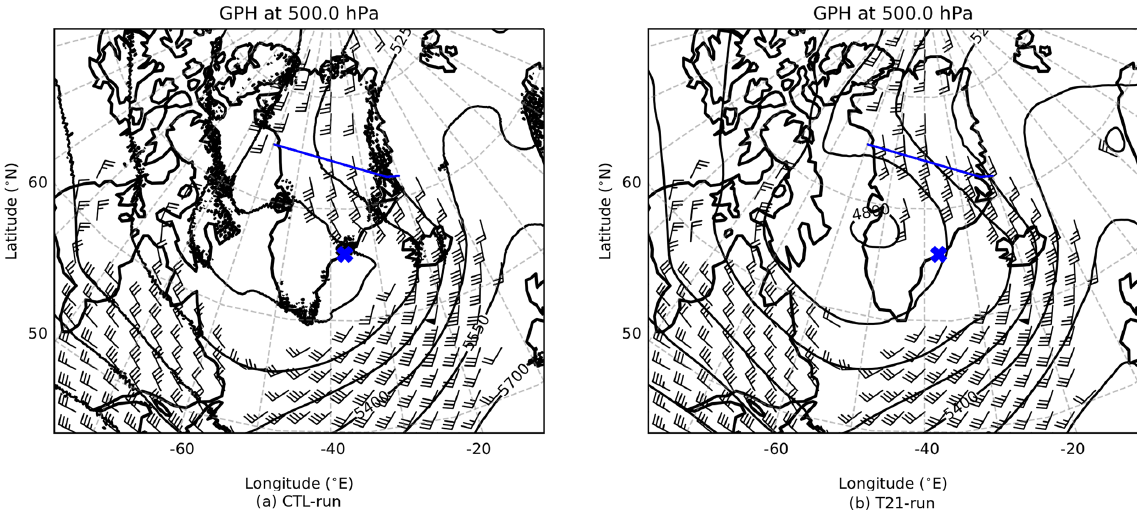
Figure 11. Geopotential heights and winds at 500hPa valid for 9 March at 18:00UTC for CTL-run (a) and T21-run (b) . Note that the spotted (especially along the coastlines) CTL-run is a result of the orographic GW drag parameterisation scheme. The rest of the display is the same as in Fig. 1, but with no potential vorticity